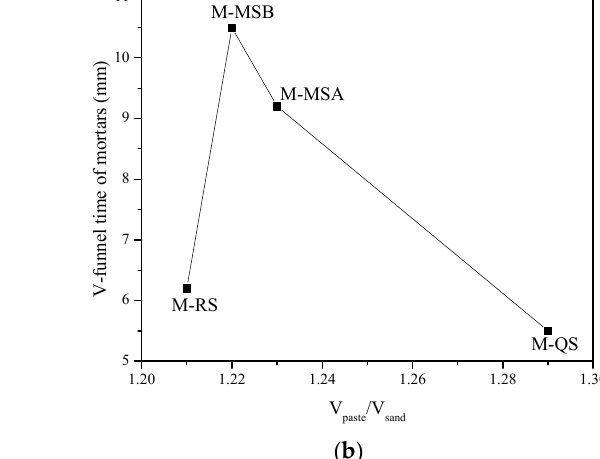
Table 4. Shape parameters and the test results of mortar of four kinds of sands (SSD).